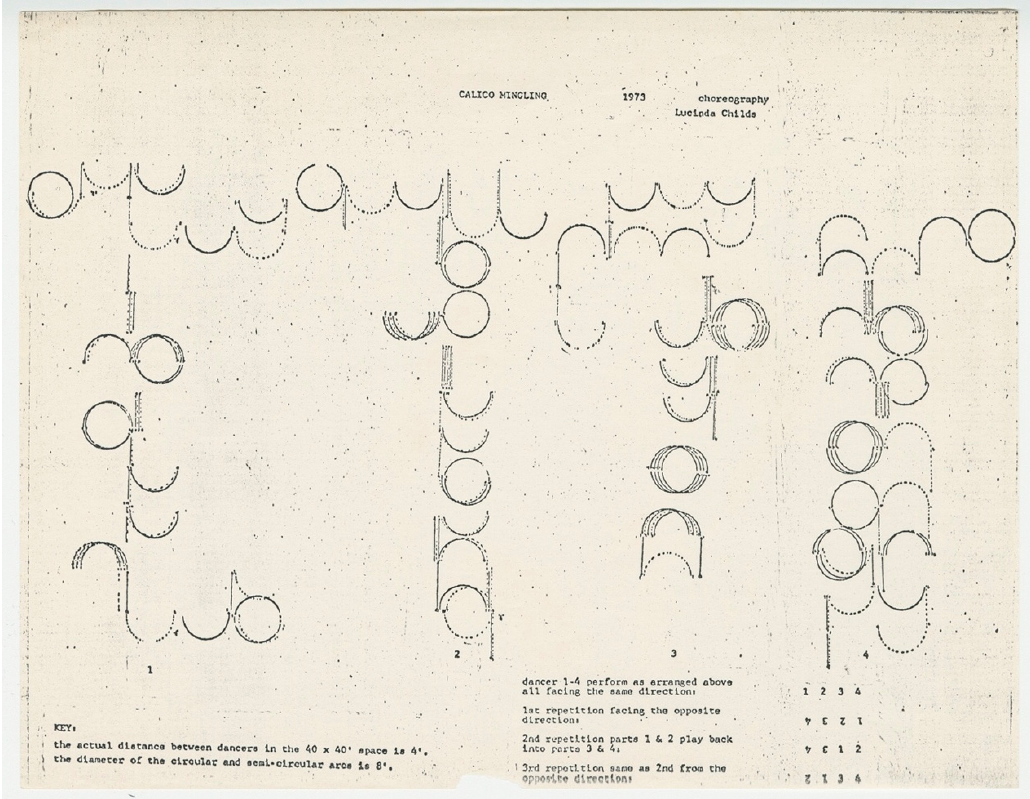
Figure 6. Lucinda Childs, reduction for Calico Mingling (1973), photocopy, 8.5” × 11”, Fonds Lucinda Childs-Médiathèque du Centre national de la danse.